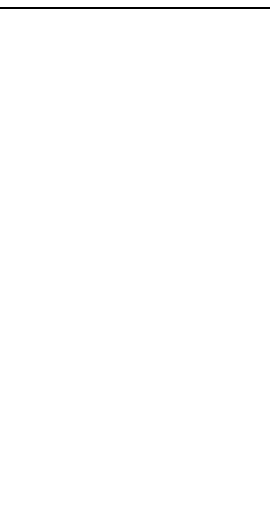
Table 2. Chemical composition of